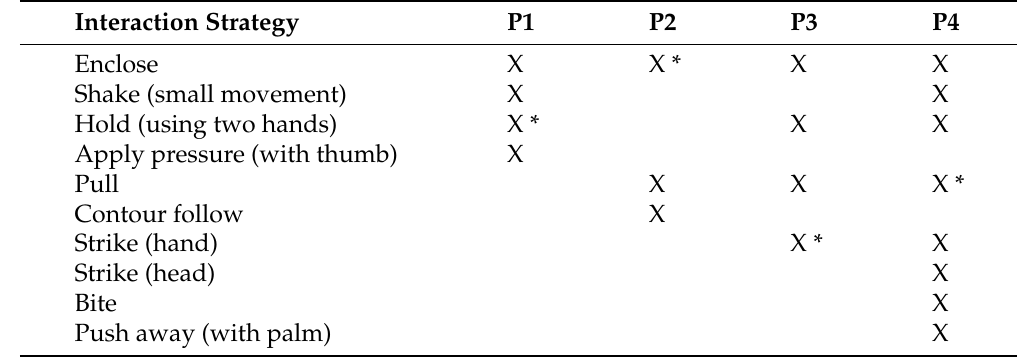
Table 4. Means of interacting with the strings. Stars (*) denote primary strategy (i.e., the method most commonly used by the respective student).